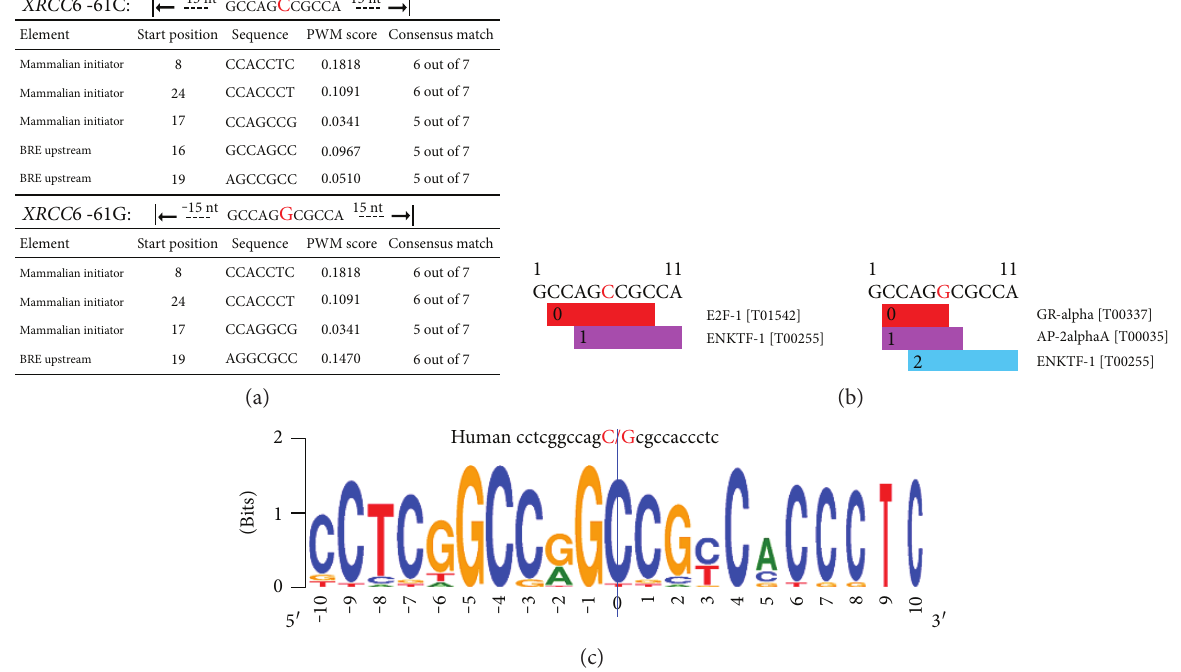
Figure 5: The prediction of core promoter elements, transcription factor binding sites, and sequence conservation of the XRCC6 -61C > G variant in the XRCC6 gene promoter: (a) prediction of core promoter elements via ElemeNT tool; (b) prediction of potential transcription factor binding sites; (c) illustration of sequence conservation of the DNA sequence around rs2267437 (C > G)